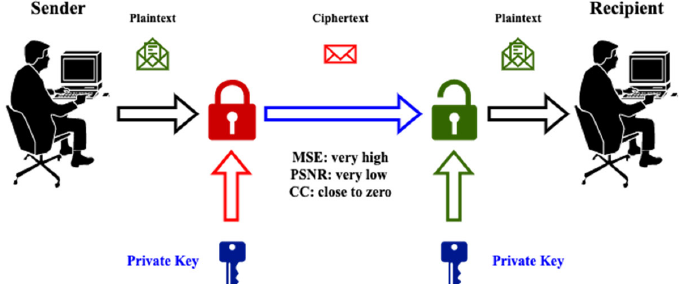
Fig. 1. Data cryptography